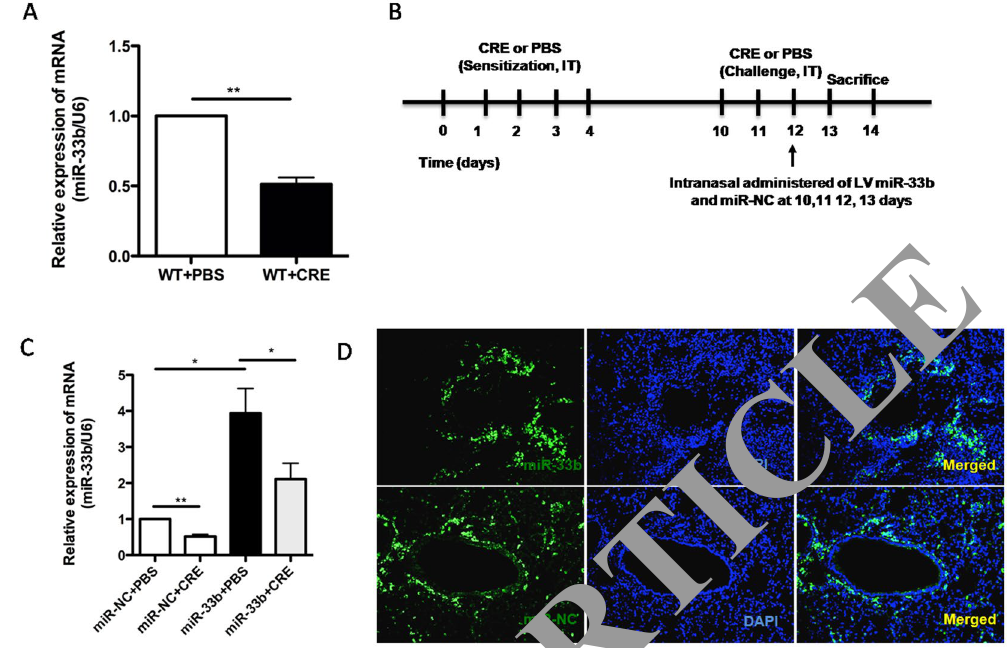
Figure 1. Expression of lentiviral miR-33b in the asthmatic mice. ( A ) qRT-PCR was used to evaluate miR-33b expression in CRE-challenged WT mice. ( B ) C57BL/6 mice were sensitized on days 0 and 4 with intra-tracheal instillations of 400 μ g/ml CRE. Non-sensitized control animals received the same volume of PBS alone. Five days after the first sensitization, the mice were challenged intra-tracheal instillation of the same concentration of CRE once only on days 10 and 13. In addition, during the challenge period, the mice were intra-nasally administered 2 × 10 6 infectious units (IFUs) of LV miR-33b or 2 × 10 6 IFUs of an empty LV vector. ( C ) qRT- PCR was used to test miR-33b expression in the miR-33b or miR-NC transfected model. ( D ) Representative images of GFP immunofluorescence in lung tissue sections of CRE-challenged WT mice that were transfected with miR-NC or miR-33b (n = 3). The data are representative of three independent experiments (n = 4–6 mice/ group). The data are presented as the means ± SEM. * P < 0.05, ** P <